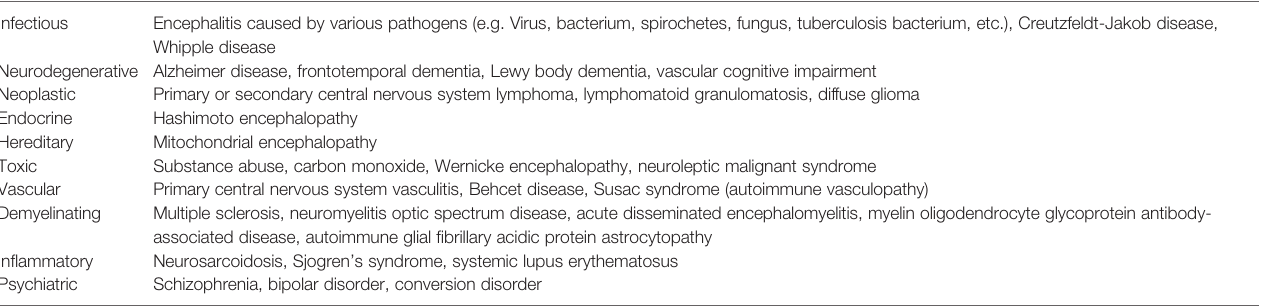
TABLE 4 | Differential diagnosis of anti-AMPAR encephalitis (2, 42 – 44). Infectious Encephalitis caused by various pathogens (e.g. Virus, bacterium, spirochetes, fungus, tuberculosis bacterium, etc.), Creutzfeldt-Jakob disease, Whipple disease